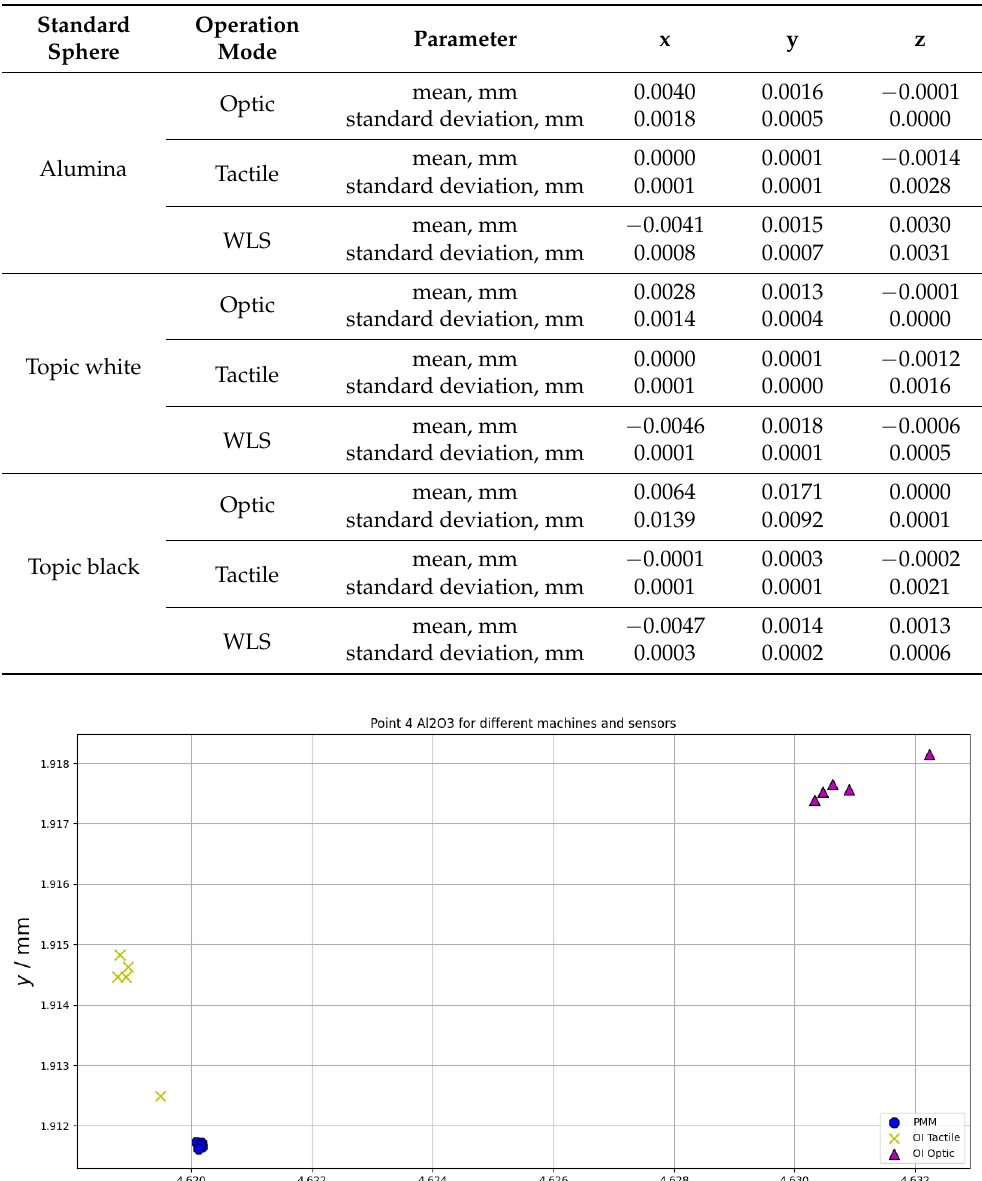
Table 3. Determination of sphere centres for measurements of spheres made of different materials performed using different sensors.